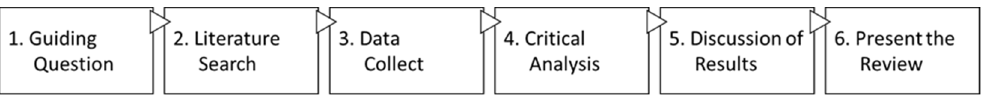
Figure 1. Steps of the Integrative Review. Source: this figure was created by authors based on Souza et al. (2010).